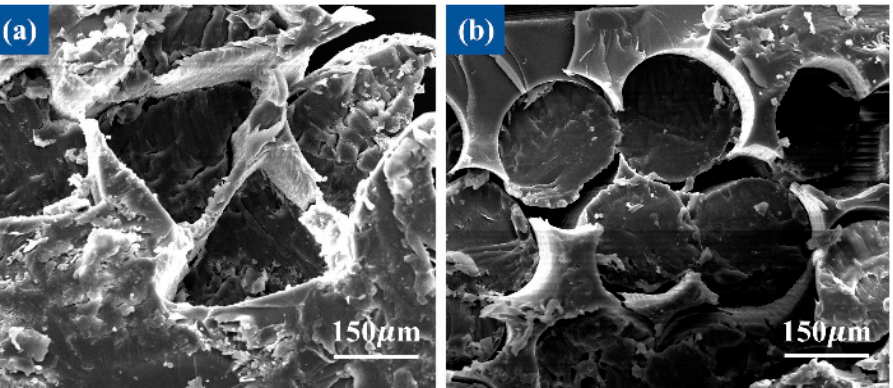
Figure 9. SEM images of the distribution of PVA triangular fibers ( a ) and circular fibers ( b ) in epoxy resin.